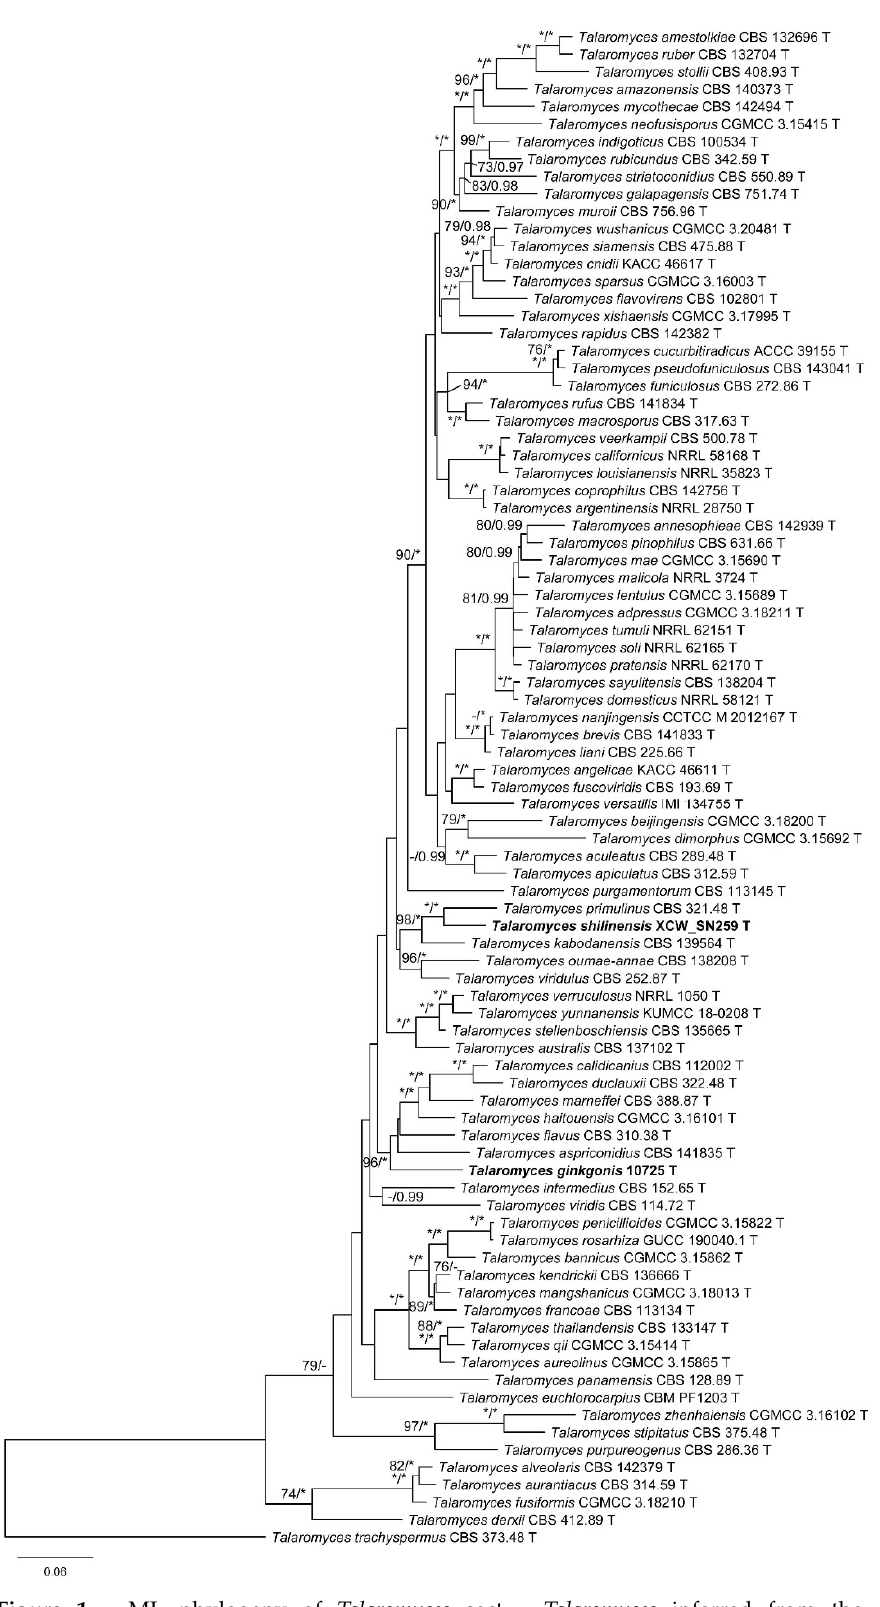
Figure 1. ML phylogeny of Talaromyces sect. Talaromyces inferred from the combined (BenA + CaM + RPB2) dataset. Bootstrap values ≥ 70% ( left ) or posterior probability values ≥ 0.95 ( right ) are indicated at nodes. Asterisk denotes 100% bootstrap or 1.00 posterior probability.